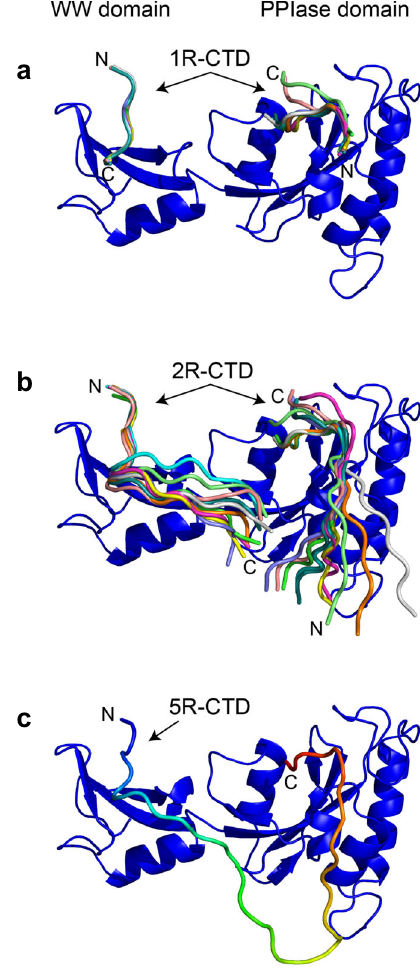
Fig. 6 Model of Ess1 interactions with CTD peptides. a 1R-CTD or 2R-CTD was docked to the WW domain or the PPIase domain of Ess1 using PDB 1F8A or PDB 3TCZ, respectively (see text). Top 10 docking structures were superpositioned with peptide direction denoted by labels for N and C- termini. b Model of simultaneous binding of two 2R-CTD peptides to the WW and Ess1 domains. Note that the C-terminus of the 2R-CTD bound to the WW domain is near the N-terminus of 2R-CTD bound to the PPIase domain. c Model of 5R-CTD peptide interacting with Ess1 using docking results from parts a and b